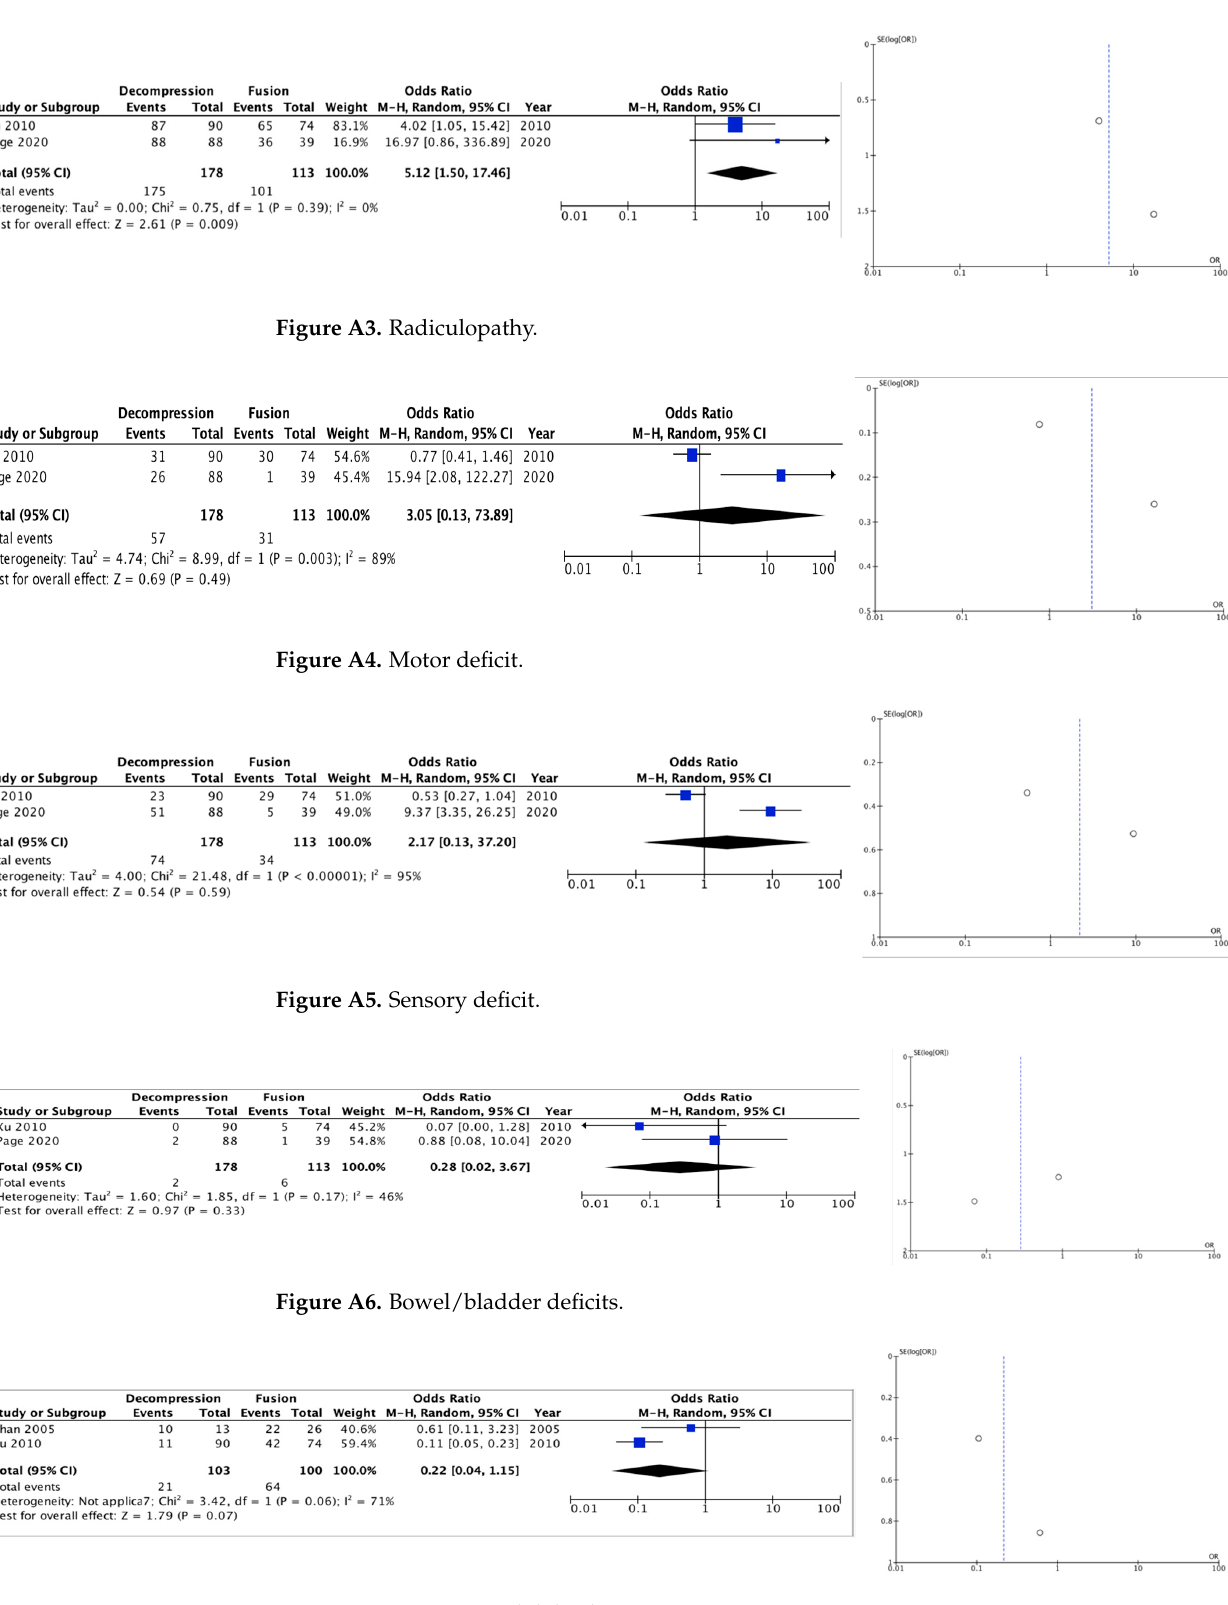
Figure A8. Cyst recurrence.